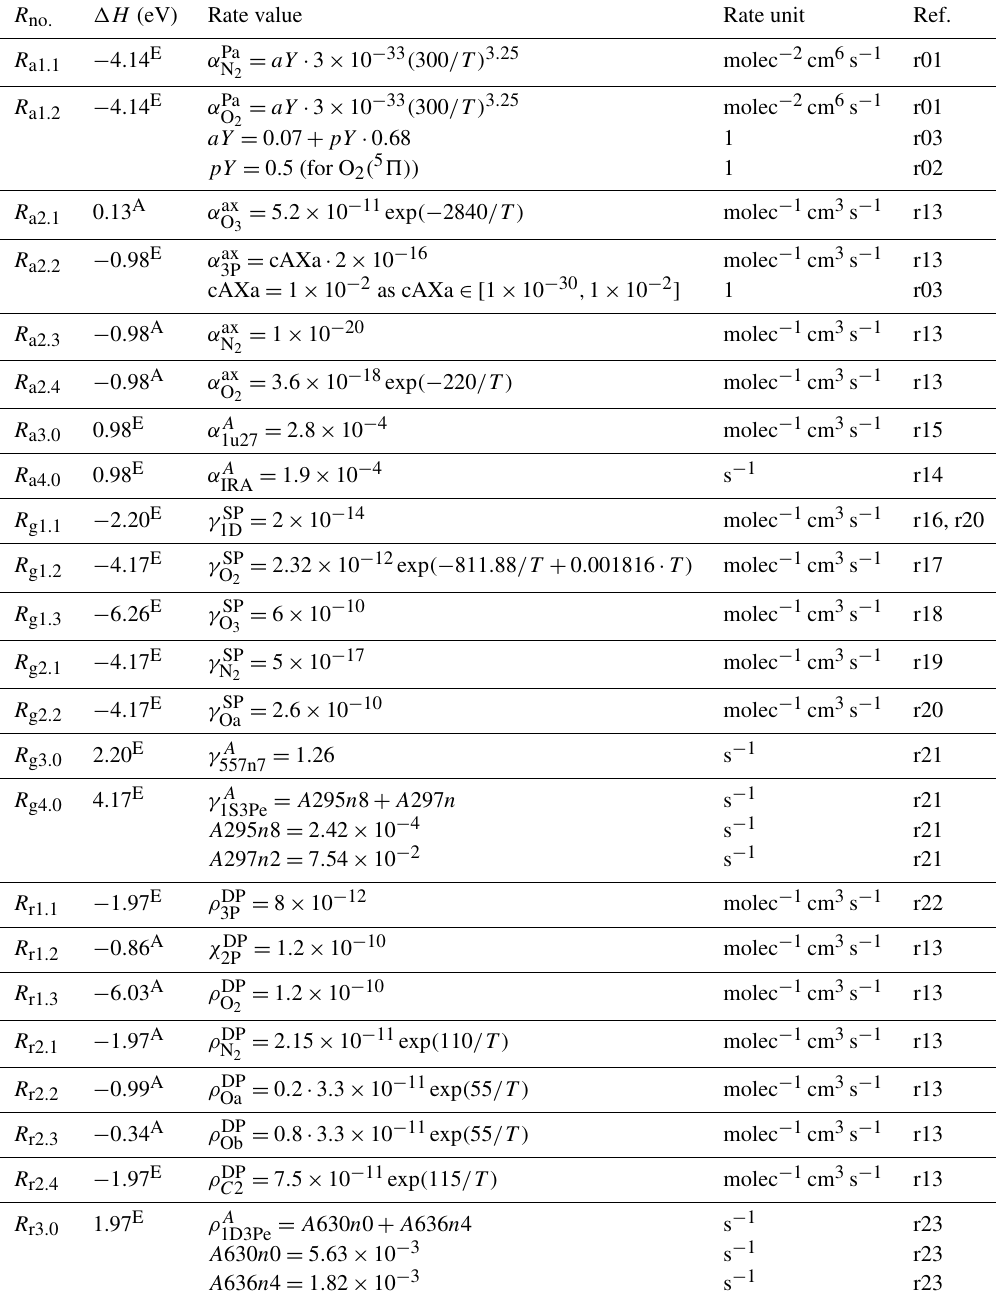
Table 10. Rate values of the processes listed in Tables 6 and 7. References: r15 – Pendleton et al. (1996), r16 – Krauss and Neumann (1975), r17 – Capetanakis et al. (1993), r18 – Gordiets et al. (1995), r19 – Atkinson and Welge (1972), r20 – Kenner and Ogryzlo (1982), r21 – Kramida et al. (2015), r22 – Pinheiro et al. (1998), r23 – Sakai et al. (2014). The labels r01, r02 and r03 were used in Table 8, and the labels r13 and r14 were used in Table 9. The enthalpy change ( (cid:49)H ) was determined at standard temperature and pressure; see Table 11 for